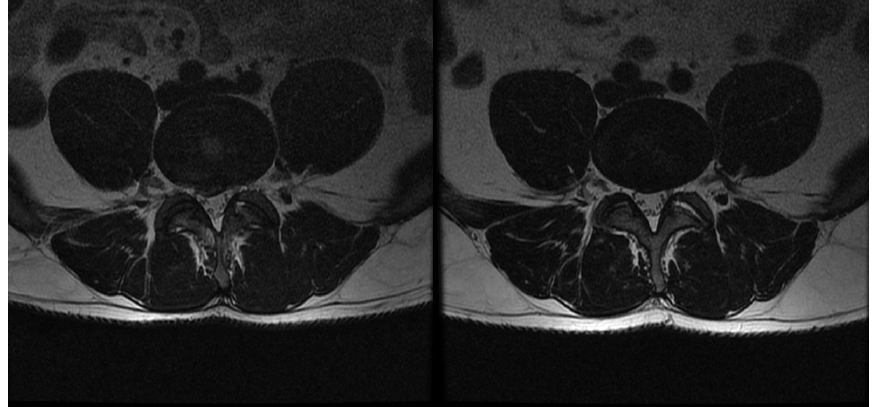
Figure 3. Pre- ( left ) and post-GEI ( right ) axial MRI at L4/L5 level of of patient with radiculopathy. MRI was performed four weeks before and six weeks after the GEI.